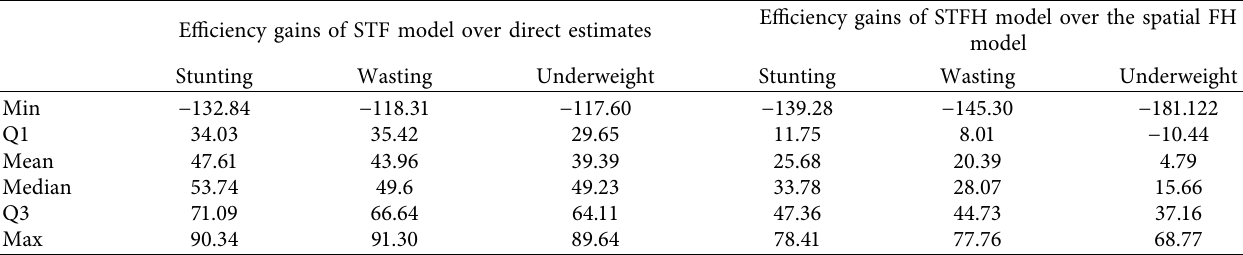
Table 3: Summary statistics of efficiency gain in CV (%) for spatiotemporal EBLUPs over direct survey estimates and spatial EBLUPs. Efficiency gains of STF model over direct estimates